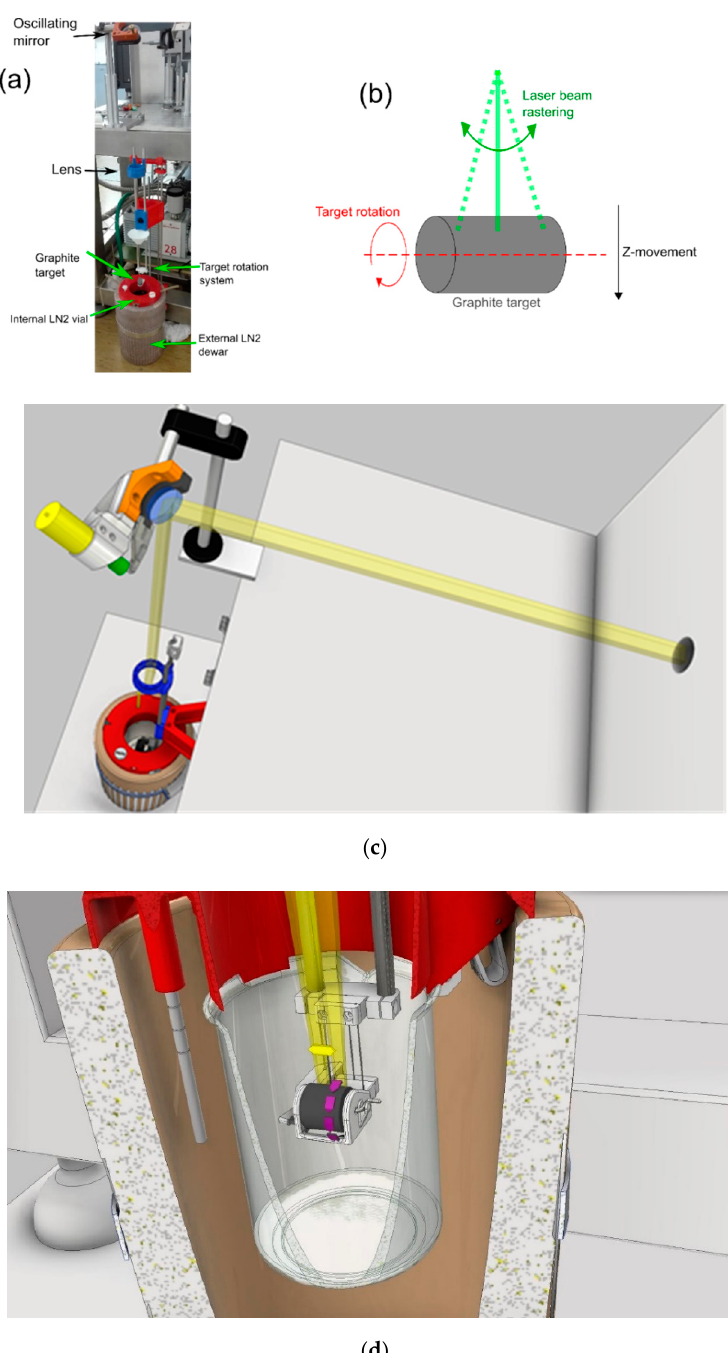
Figure 1. ( a ) Experimental apparatus. ( b ) Schematics of the oscillating mirror automatized system. The laser beam is made to impinge the cylinder surface at 45°. ( c ) Details of the experimental apparatus. The yellow transparent line is the 248 nm high fluence laser beam. The steering mirror reflects it through a 400 mm focal lens (fixed inside the blue circular holder). The graphitic target is fully immersed inside a LN 2 bath. ( d ) Graphite cylindrical target with a view of the roto-step- translational system, which lets the target rotate when the laser impinges on the sample.